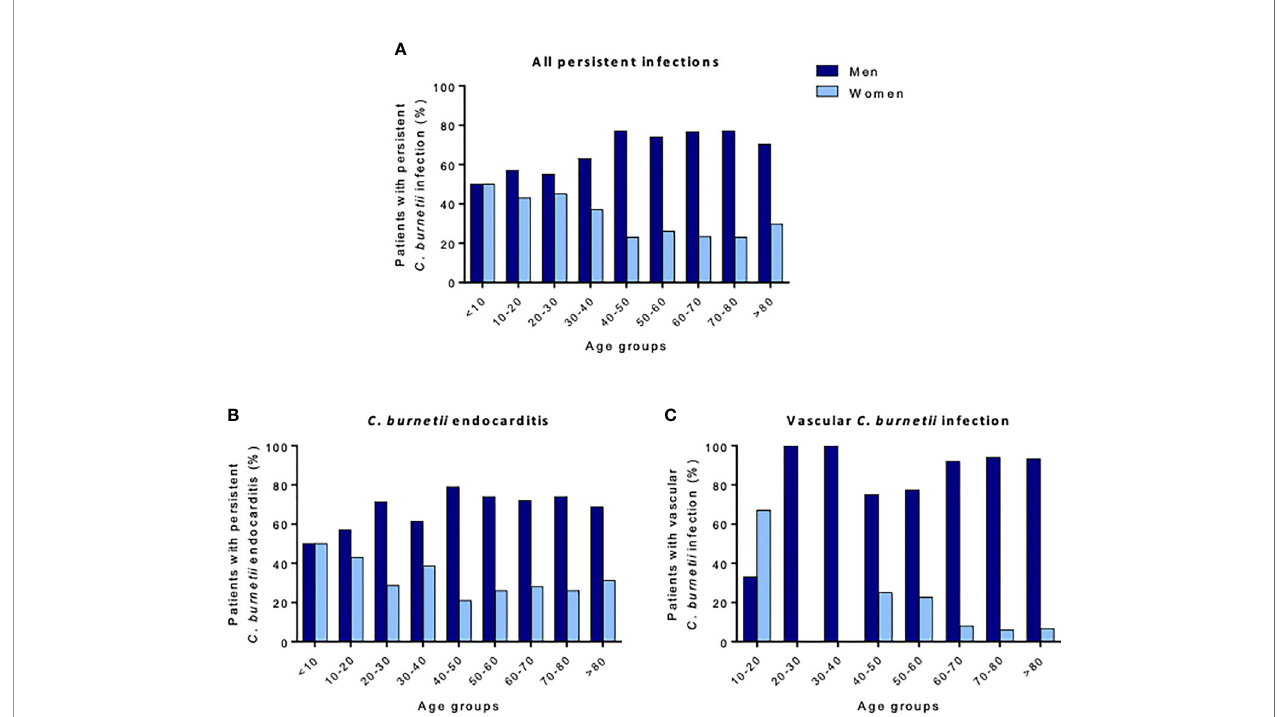
FIGURE 6 | Percentage of patients with persistent C. burnetii infection regarding sex and age. The proportion of men and women patients for (A) all persistent C. burnetii infections, (B) C. burnetii endocarditis, and (C) vascular C. burnetii infections are presented. In children, persistent C. burnetii infection affects girls and boys similarly, whereas adult men are mostly affected. After 40 years of age, men represent more than 70% of patients.